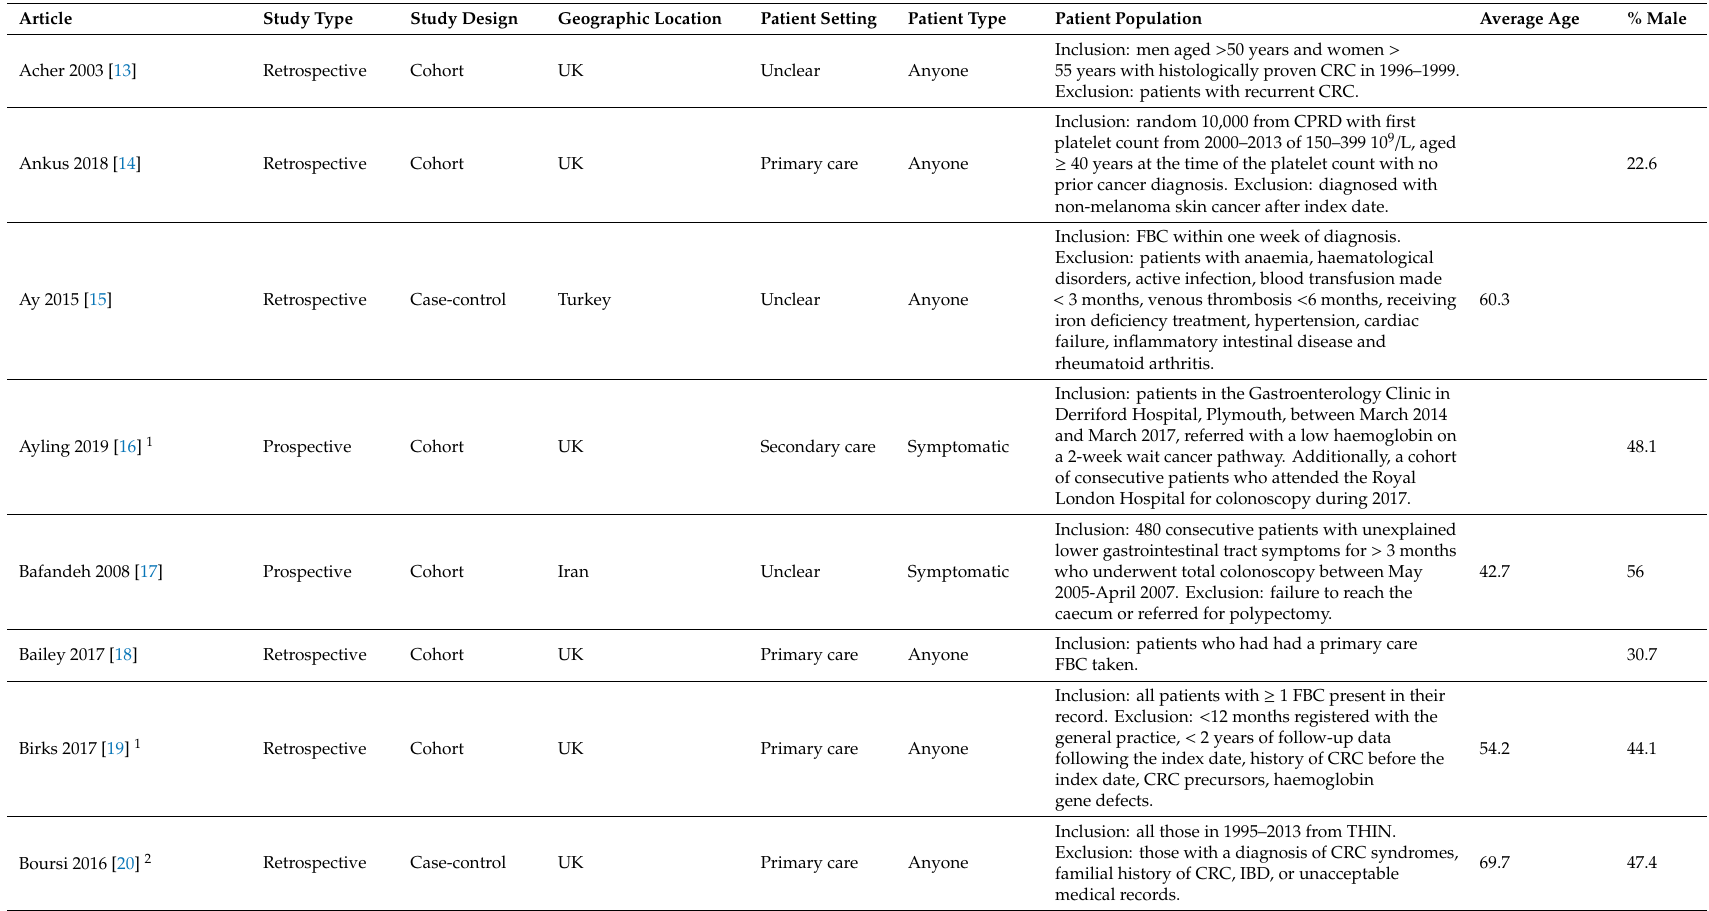
Table 1. Description of the 53 studies included in the